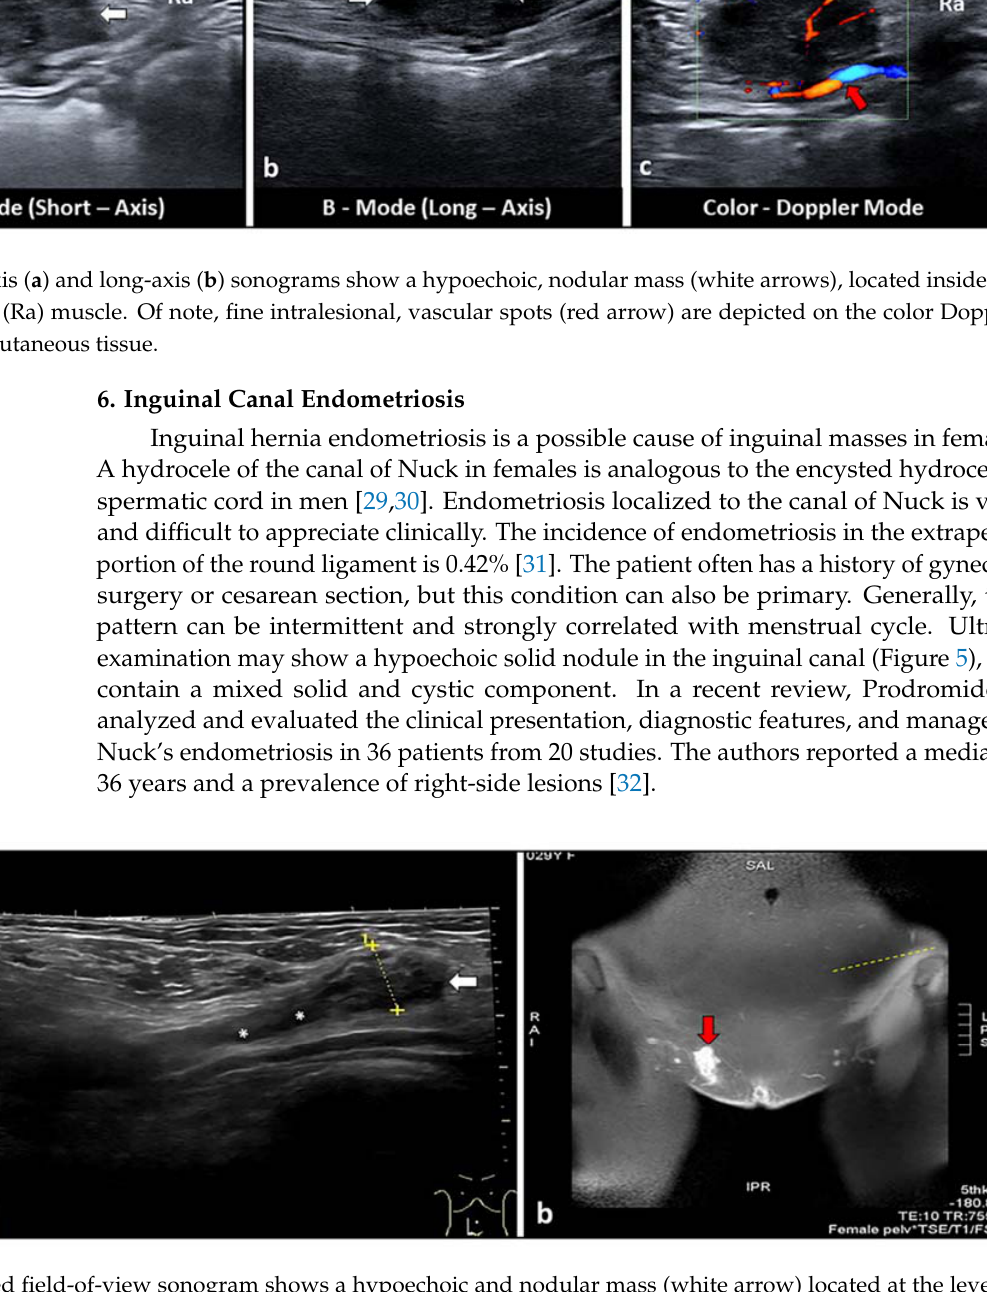
Figure 5. Extended field-of-view sonogram shows a hypoechoic and nodular mass (white arrow) located at the level of the Nuck canal (white asterisks) ( a ). Coronal T1-weighted MR image showing a hyperintense, pseudo-nodular mass (red arrow), confirming the presence of a hemorrhagic focus inside the inguinal canal representing endometriosis foci ( b ).